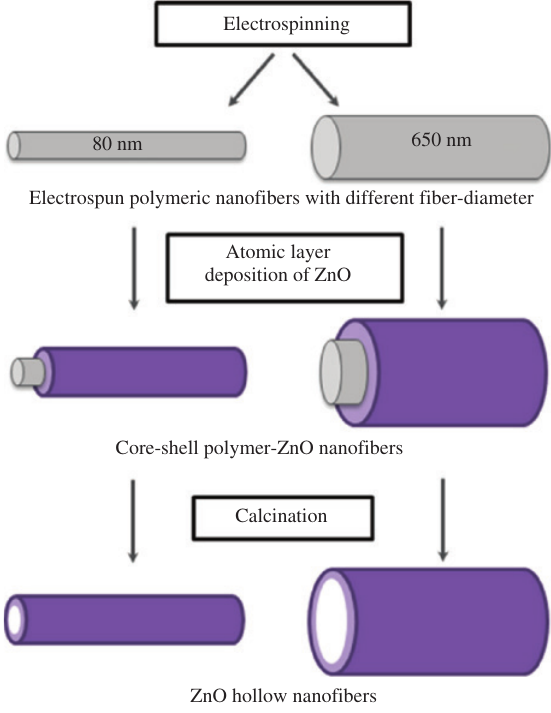
Figure 6: Schematic diagram depicting the steps involved in the production of core-shell and hollow nanofibers. Reprinted with permission from Ref. [50]. Copyright 2015 Elsevier